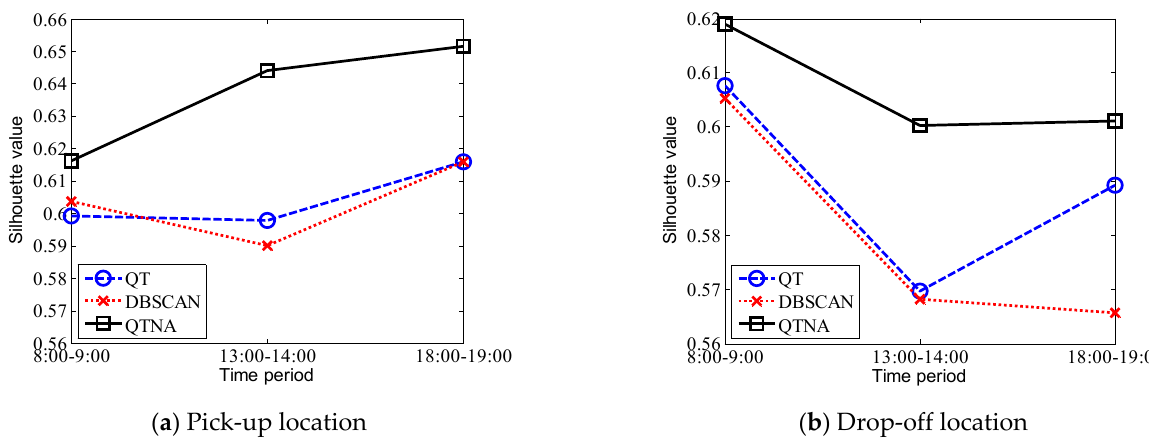
Figure 5. Performance comparison of clustering algorithms. ( a ) shows the clustering results based on the pick-up locations during different time periods on the same day. ( b ) shows the clustering results based on the drop-off locations during different time periods on the same day.